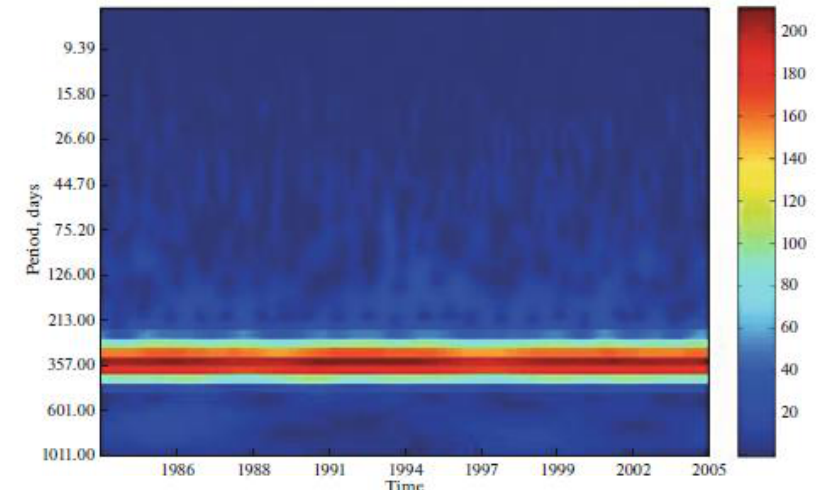
Fig. 2. The frequency-time diagram of the average